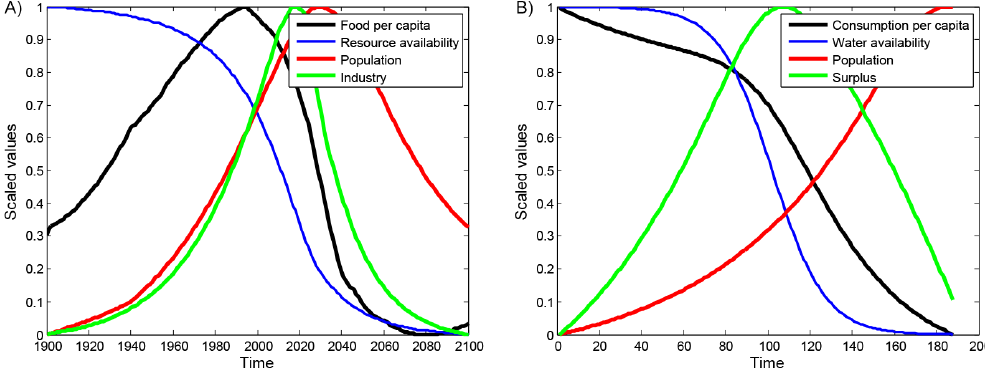
Figure 4. (a) World3 model output for business-as-usual scenario (Hayes, 2012). (b) Output of the endogenous technological change model presented here. All the variables in both the figures have been scaled between 0 and 1 by subtracting the minimum and dividing by the range. Variables “food per capita”, “resource availability” and “industry” in (a) are equivalent to “consumption per capita”, “water availability” and “surplus” in (b)